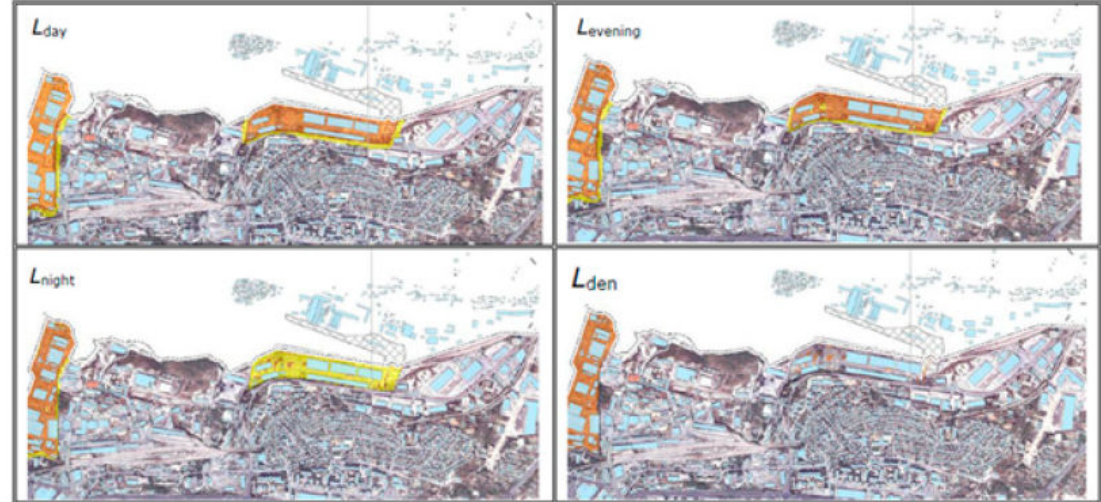
Figure 6. Strategic maps of industrial noise sources in the evaluation periods (L day , L evening , L night , L den ) * [55]. * noise indicator class (dB) as in Figure 4.